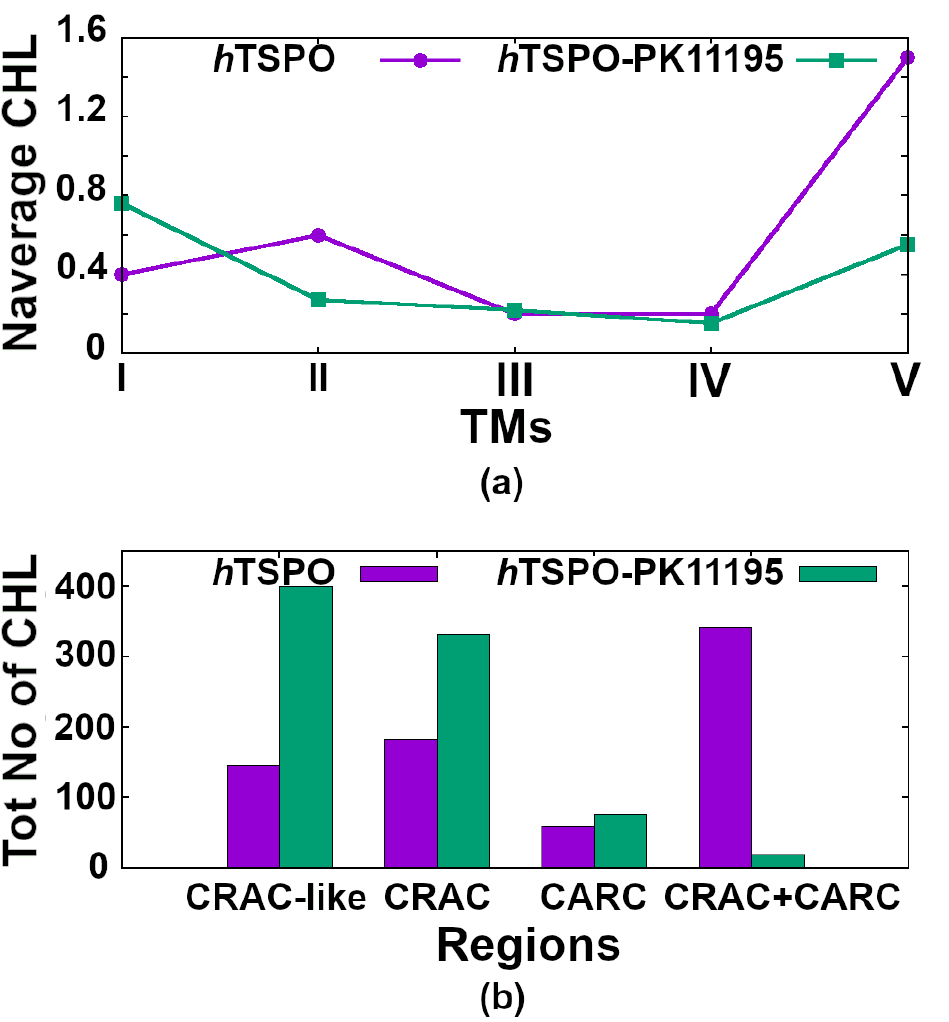
Figure 7. ( a ) The average number of cholesterol molecules (Naverage CHL) binding to the individual helix (TM I–TM V) in the apo (violet line) and holo (green line) h TSPOs at each frame of the 1 µ s MD trajectory. ( b ) The total number of all cholesterol molecules (Tot No of CHL) binding either to the CRAC-like motif in TM I or to the CRAC and/or CARC in TM V during our 1 µ s long MD simulation of apo h TSPO (violet) and holo h TSPO